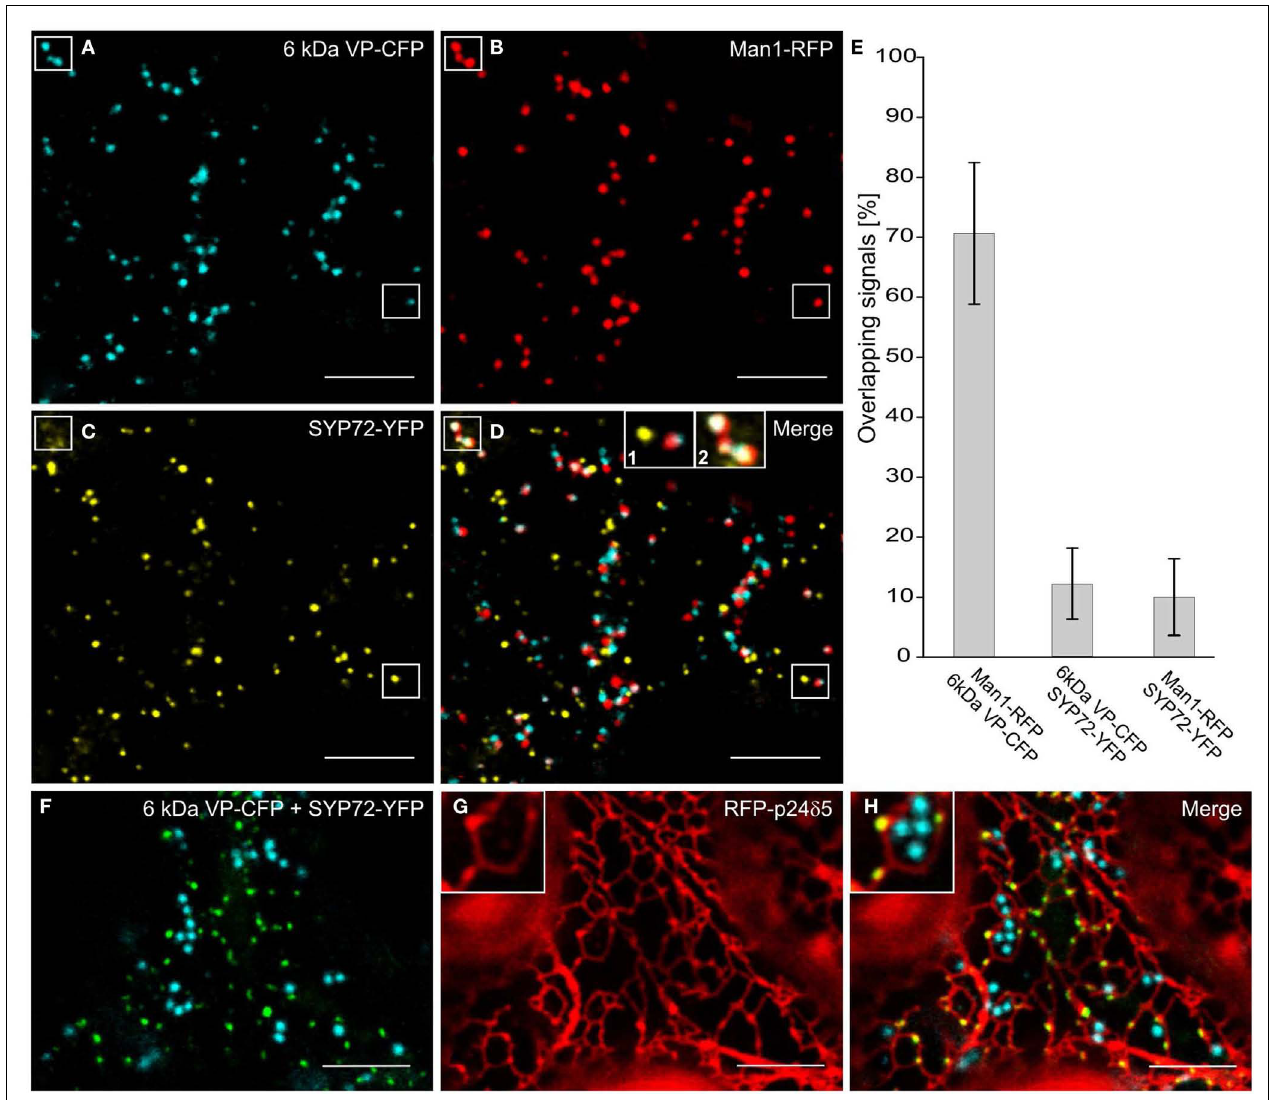
and Man1-RFP punctae is indicated in the rectangles in (A–C) , and in inset 2 in (D) When tobacco leaves were triple agroinfiltrated with 6kDaVP-CFP, SYP72-YFP, and RFP-p24 δ 5 a clear distinction can be made between the punctate SYP72-YFP signals which lie directly on the tubular ER network (see insets in (G,H) for nodules) and the Golgi-associated ERES marker [6kDaVP-CFP; (F–H) ]. Magnification bars = 10 µ m (A–D,F–H)